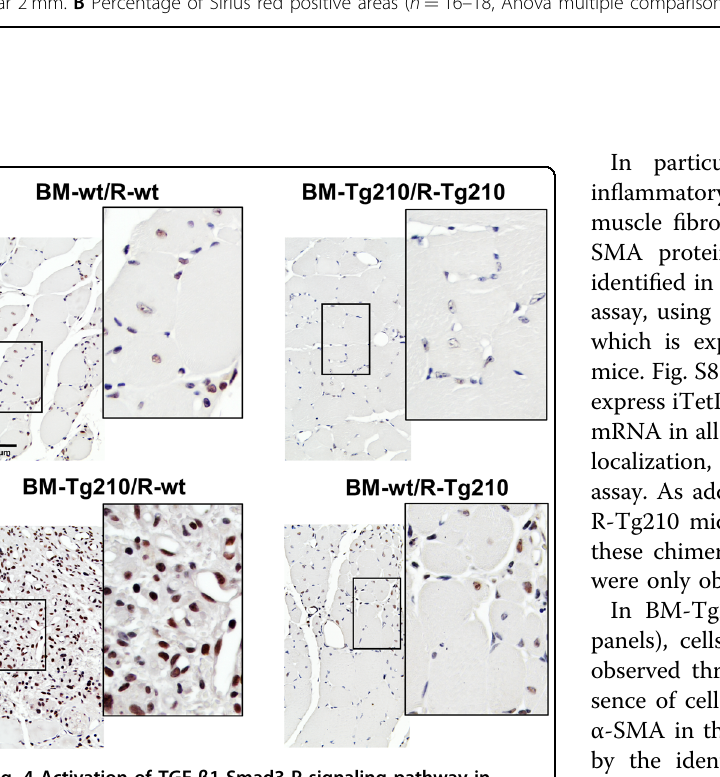
Fig. 4 Activation of TGF- β 1-Smad3-P signaling pathway in ischemic BM-Tg210/R-wt gastrocnemius muscles. Representative images of anti-phospho-Smad3 IHC of ischemic gastrocnemius muscle sections of BM-wt/R-wt, BM-Tg210-R-Tg210, BM-Tg210-R-wt, and BM-wt/R-210 chimeric mice. Positive nuclei are stained in brown/ black (Smad3-P + hematoxylin), negative nuclei are stained in blue (hematoxylin alone). Magni fi cation ×400, calibration bar 50 µm. Insets show magni fi cations of the indicated